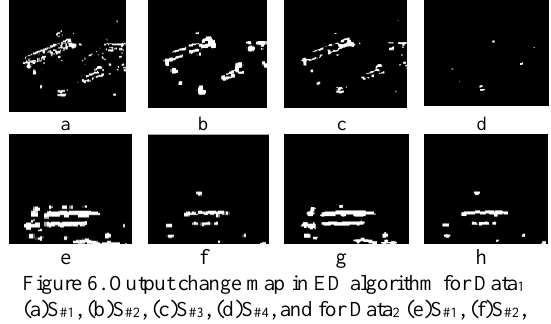
Figure 4. Output change map in TA algorithm for Data 1